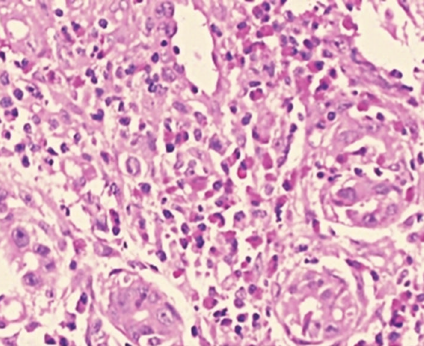
Figure 3: Colon biopsy shows colitis with marked eosinophilic infiltration of the colonic mucosa (H&E stain, ×